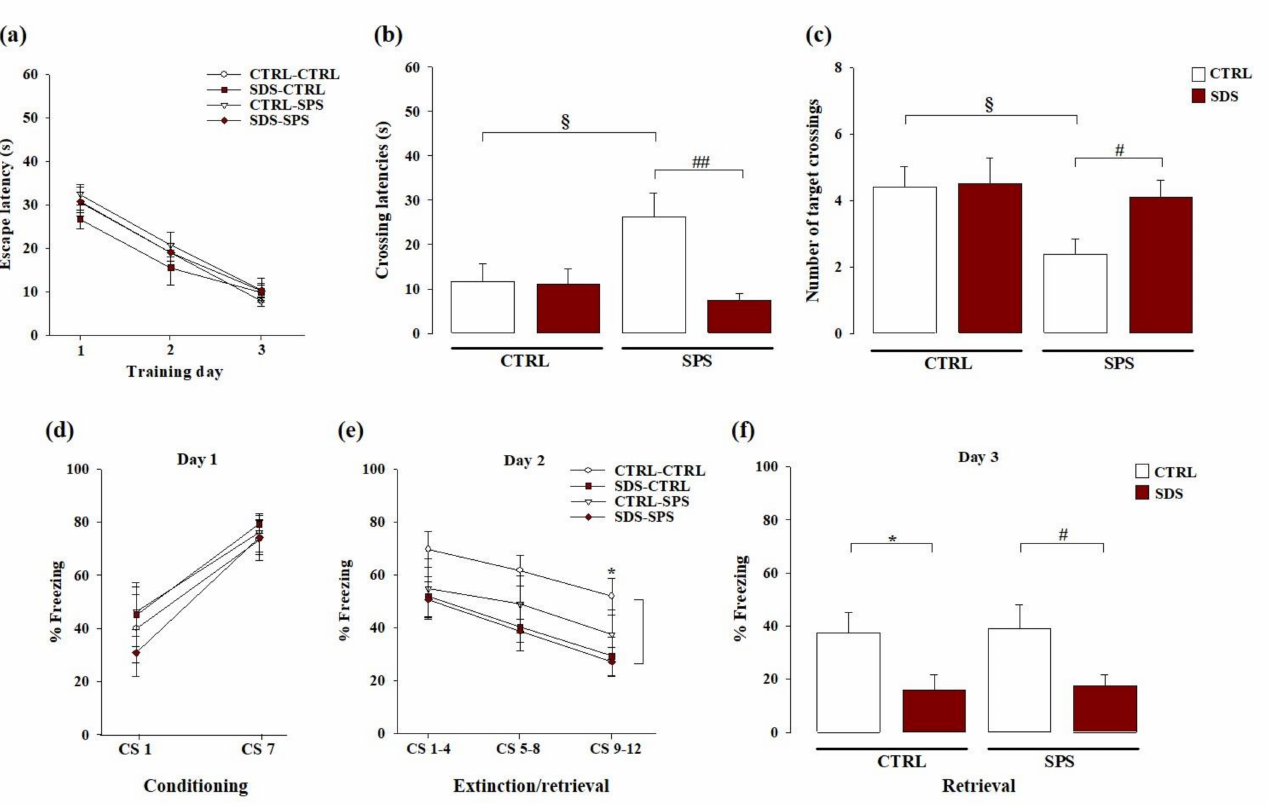
Figure 3. Long-term effects on spatial and cued fear memory dynamics induced by SDS, SPS, or the combination of both stressors. Long-term effects induced by SDS, SPS, or both stressors in the Morris water maze on ( a ) escape latencies across trials during each day of the acquisition phase, ( b ) the latency to cross the platform location, and ( c ) the number of crossings over the platform location during the probe session. Long-term effects induced by SDS, SPS, or both stressors in the auditory fear conditioning paradigm on ( d ) percentage of time spent in freezing during the first and last tone presentations at conditioning (day 1), ( e ) mean percentage of time spent in freezing during the three blocks of four trials each at extinction (day 2), ( f ) mean percentage of time in spent freezing during all eight trials at extinction retrieval (day 3). *, p < 0.05 vs. CTRL-CTRL group; §, p < 0.05 vs. CTRL-CTRL group; #, p < 0.05 vs. CTRL-SPS group; ##, p < 0.01 vs. CTRL-SPS group. (N = 8–11 rats per group or N = 8–12 rats per group, in the Morris water maze or auditory fear conditioning tasks,